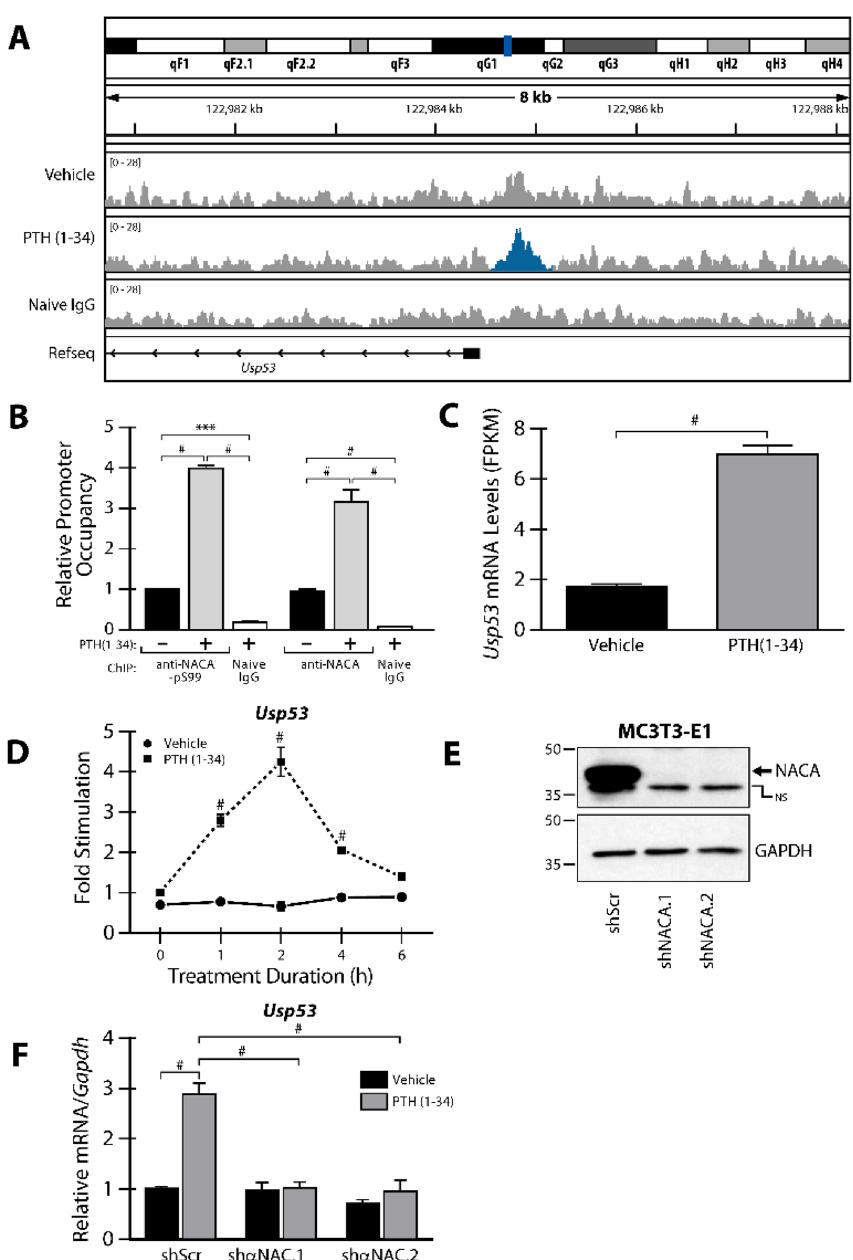
Figure 1. ChIP-Seq and RNA-Seq identify Usp53 as a target of the PTH-NACA axis in osteoblasts. ( A ) Annotated screenshot given by the Integrative Genomics Viewer (IGV) showing NACA-ChIP-Seq peak (highlighted in blue) detected in the proximal region of the Usp53 promoter. ChIP-Seq was performed with anti-NACA-pS99 antibody or naïve IgG on MC3T3-E1 cells induced or not with 100 nM PTH(1–34) for 30 min. ( B ) NACA binds the proximal Usp53 promoter. Quantitative chromatin immunoprecipitation (ChIP) was performed with anti-NACA-pS99-specific antibody, pan-specific anti-NACA antibody, or naive IgG on MC3T3-E1 cells induced or not with 100 nM PTH(1–34) for 30 min. Inputs and bound DNA sequences were amplified by Real Time PCR (RT-PCR) using SYBR green technologies and specific primers flanking the NACA binding site within the Usp53 promoter. Relative promoter occupancy was calculated as enrichment over vehicle treated cells and results are means ± SD of three independent experiments (n = 3). ( C ) Induction of Usp53 mRNA expression post treatment by PTH(1–34) for 1 h as determined by RNA-sequencing. Results are shown as fragments per kilobase of exon per million fragments mapped (FPKM), as given by RNA-sequencing. ( D ) RT-qPCR analysis of mRNA expression for Usp53 in primary osteoblast cells treated with vehicle or 100 nM PTH(1–34) for the indicated time points. ( E ) Immunoblot of whole cells extracts from MC3T3-E1 cells stably expressing shRNAs targeting Naca (shNACA.1 and shNACA.2) and scrambled shRNA (shScr) as control. Membranes were probed with anti-NACA and anti-GAPDH antibodies (as loading controls). Specific binding to NACA proteins is denoted by the arrow and NS indicates non-specific binding of the NACA-antibody. Full- length blots are presented in Supplementary Figure S4. ( F ) RT-qPCR analysis of mRNA expression of Usp53 in stably transfected MC3T3-E1 cells (shScr, shαNAC.1, or shαNAC.2) treated with vehicle or 100 nM PTH(1–34) for 2 h. Data are expressed relative to levels measured in the shScr expressing cells treated with vehicle. Results are means ± SD of three independent experiments (n = 3). # P < 0.0001; ANOVA with Bonferroni’s post-hoc test for panels B , D , and E ; unpaired t test was used for panel C